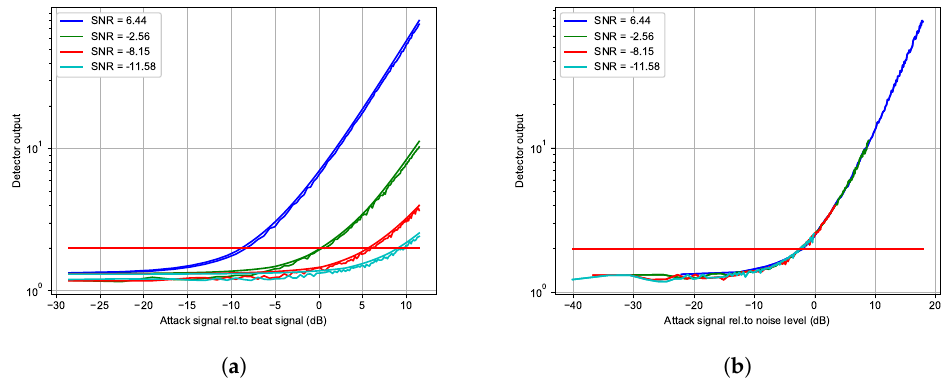
Figure 12. Test case eTX2. The horizontal orange colored line is the detection threshold. In ( a ) with respect to the beat signal level, and in ( b ) with respect to the noise